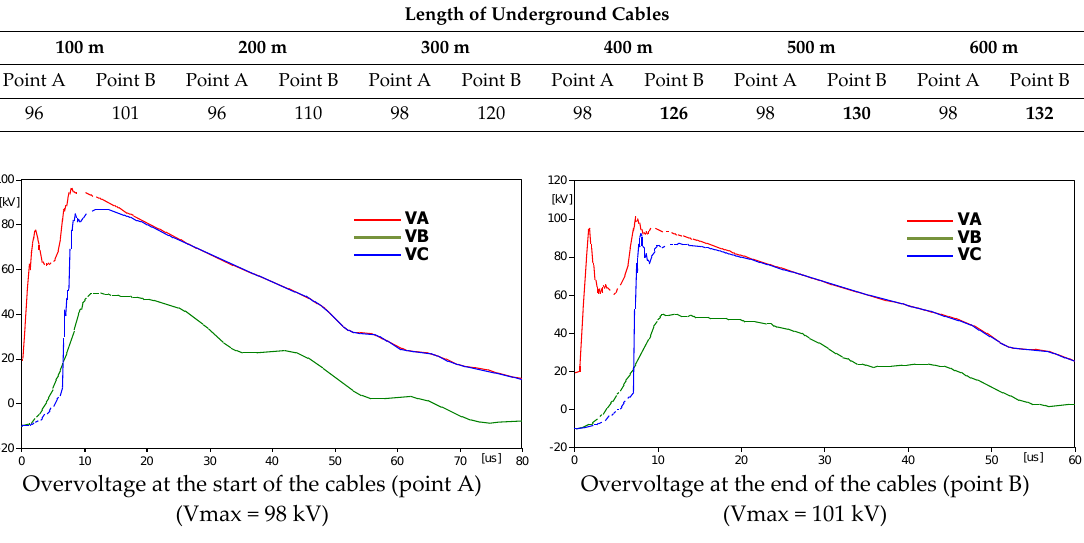
Figure 34. System is protected by lightning arrester at the conjunction of overhead line and underground cables. Table 7. Maximum overvoltage (kV) at point A and B, where the current of the lightning strike to point A is 40 kA.